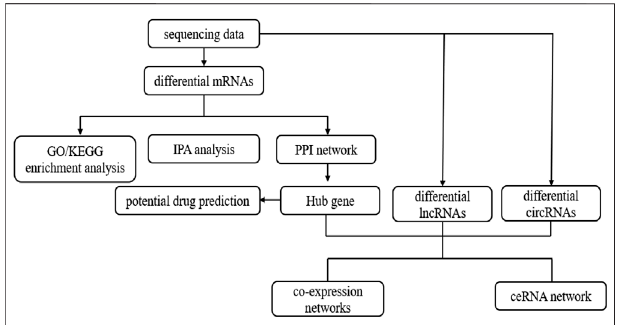
FIGURE 1 | Flowchart describing the schematic overview of the study